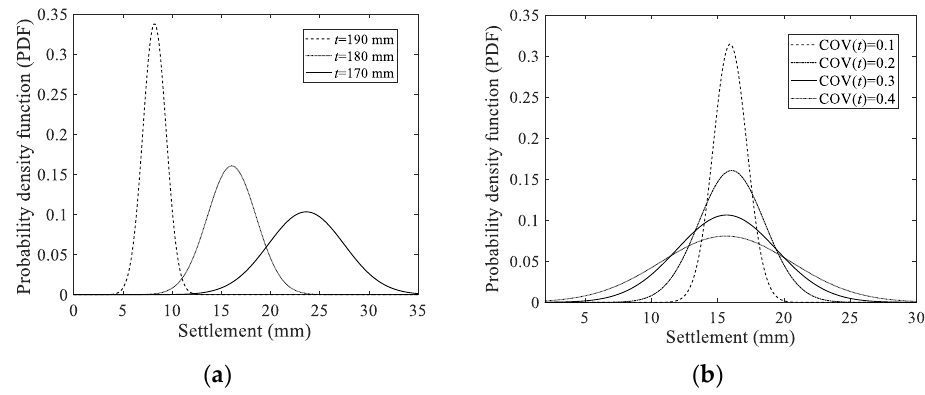
Figure 10. Effect of the grouting-layer parameters on settlement. ( a ) Grouting-layer thickness; ( b ) COV( t ).